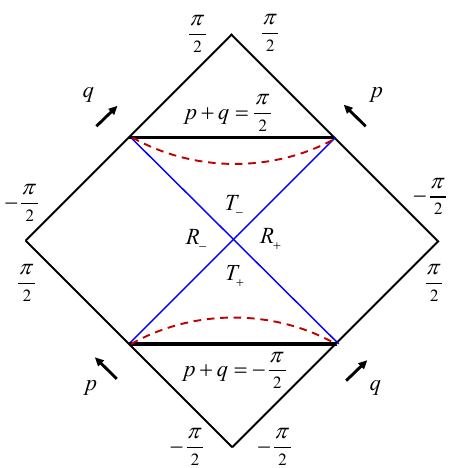
Figure 1. Conformal diagram for the spacetime of the eternal 2D black hole. Dashed lines represent junction surfaces where the curvature reaches its maximal value R = Λ